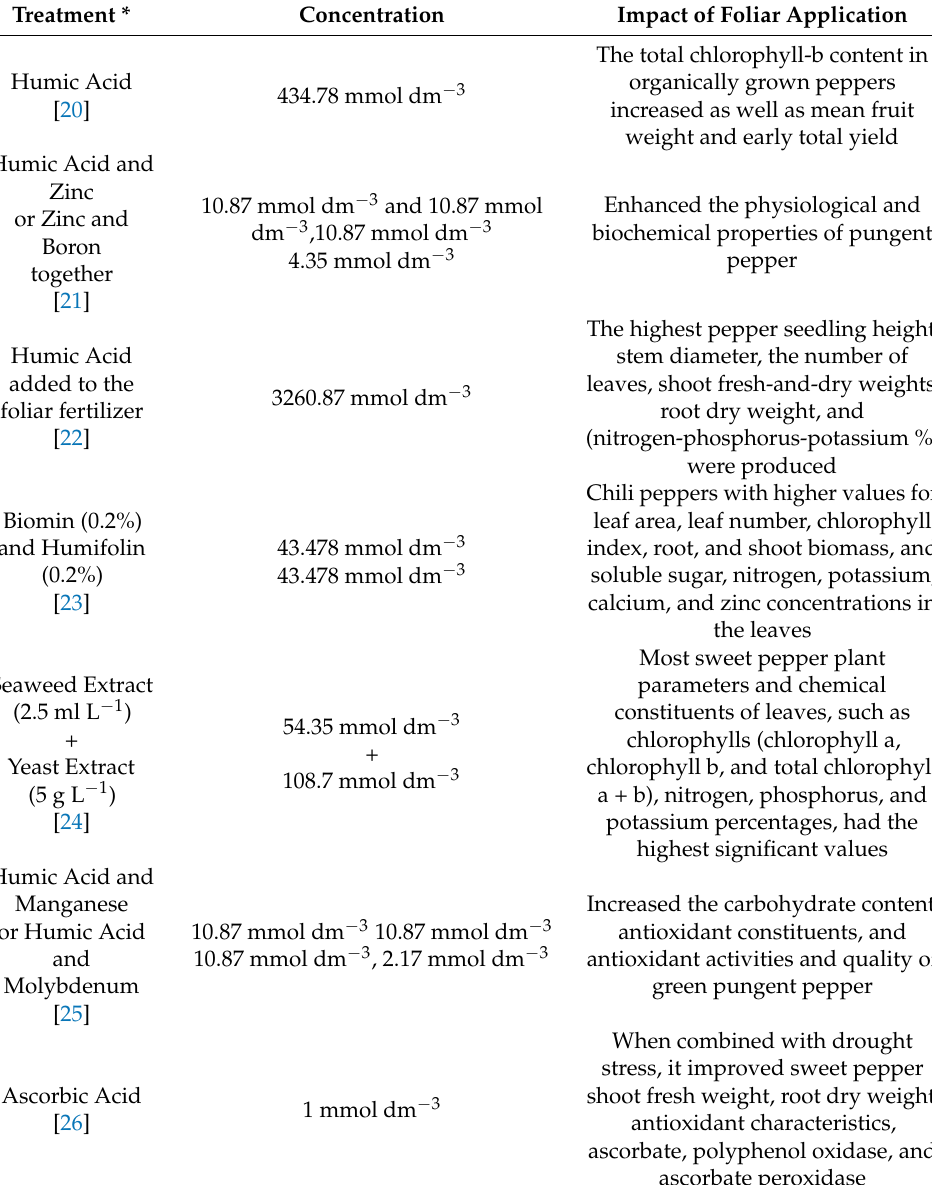
Table 3. Impact of tests of humic and ascorbic acid foliar application in